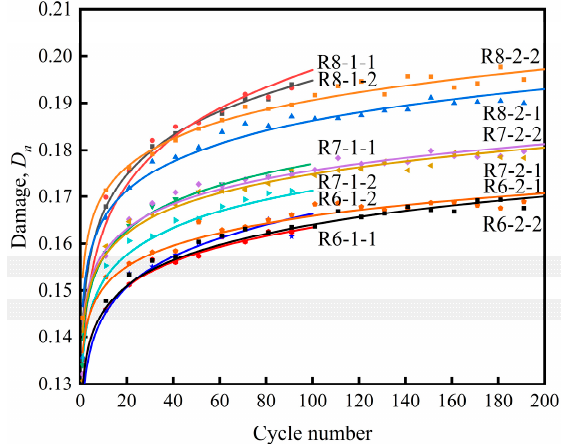
Figure 13. The relationship between the rock specimen damage variable and cycle number under three different stress upper limits in the cyclic loading and unloading tests.